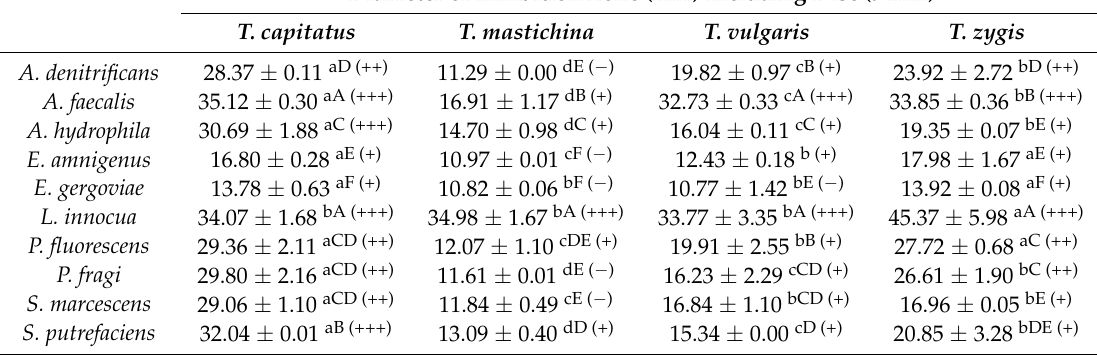
Table 2. Antibacterial activity of T. capitatus , T. mastichina , T. vulgaris and T. zygis EOs against several bacterial strains using minced beef extract as culture